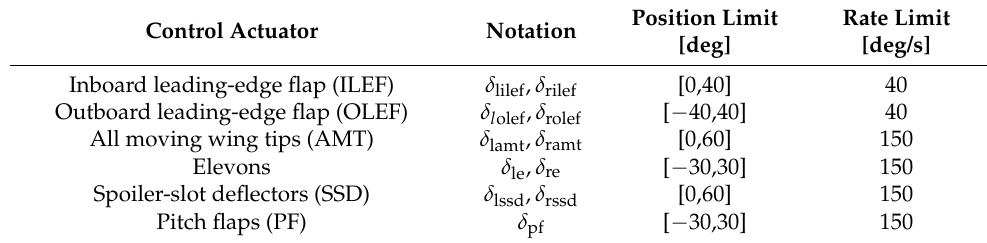
Table 3. Dynamic characteristics of the ICE control